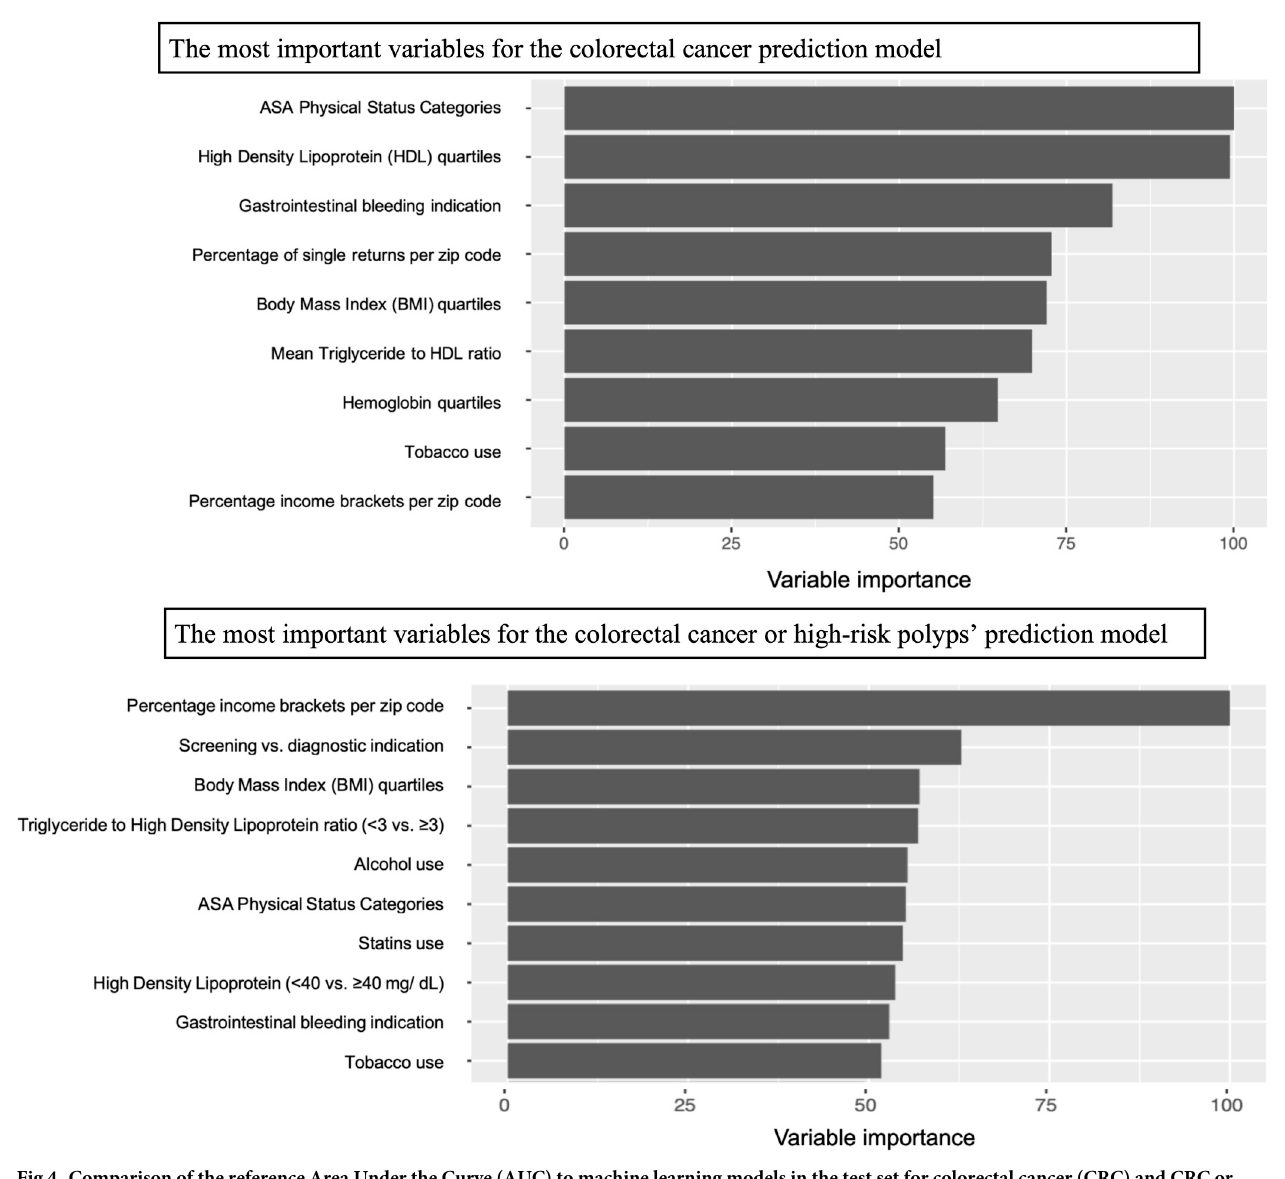
Fig 4. Comparison of the reference Area Under the Curve (AUC) to machine learning models in the test set for colorectal cancer (CRC) and CRC or high-risk polyps.